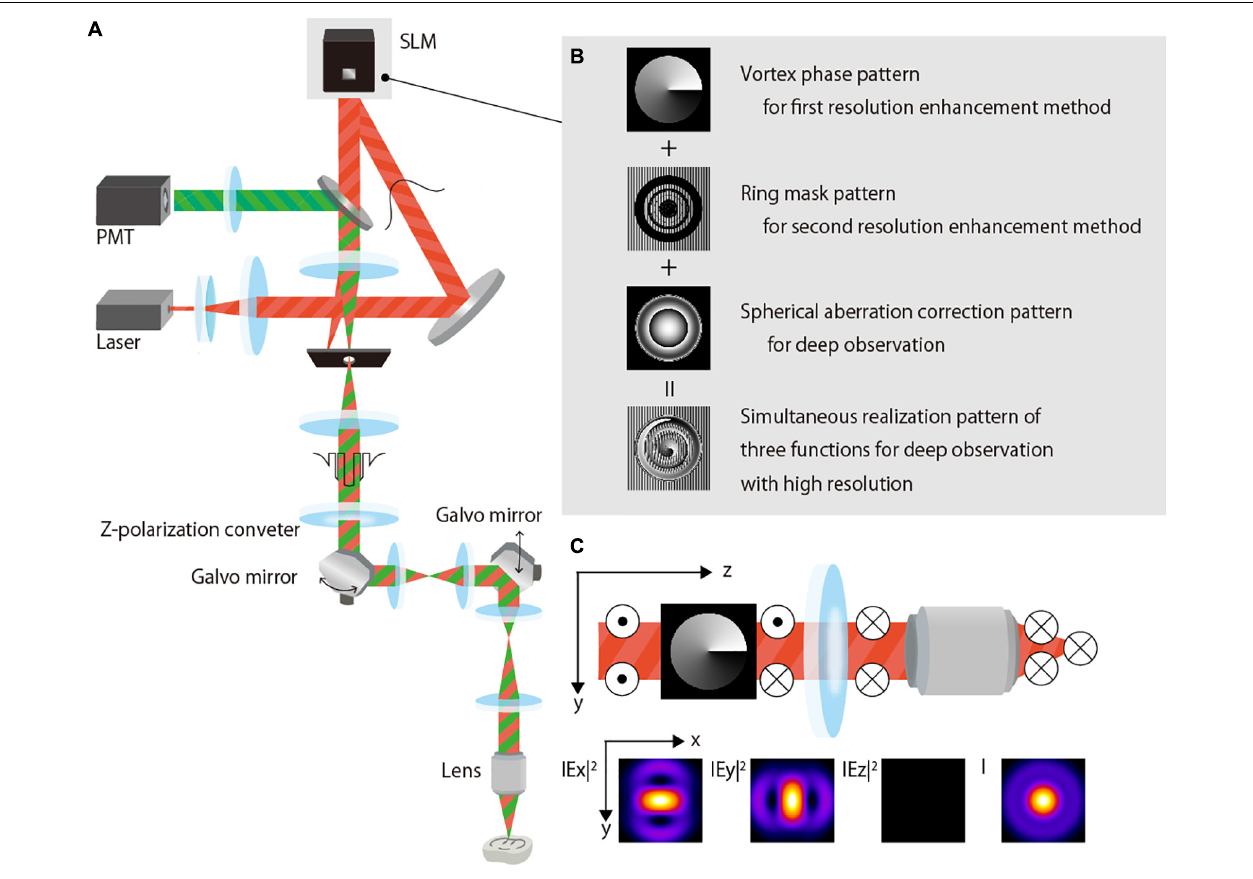
FIGURE 1 | Proposed two-photon excitation fluorescence microscopy. (A) Schematic of the optical system setup. (B) Phase-modulation pattern for application in the SLM for the complex-amplitude modulation of the excitation beam. (C) Polarization and electric field of the azimuthally polarized vortex beam.